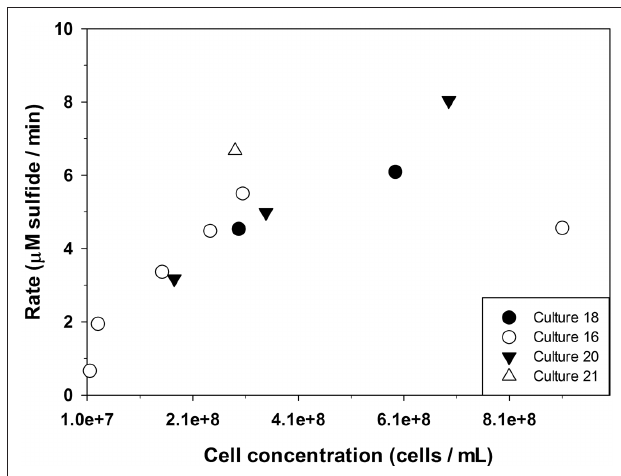
Figure 6 | The relationship between the rate of sulfide loss and varying C. tepidum cell counts from independent cultures in exponential phase growth with 5 μmol photons m − 2 s − 1 of light intensity.